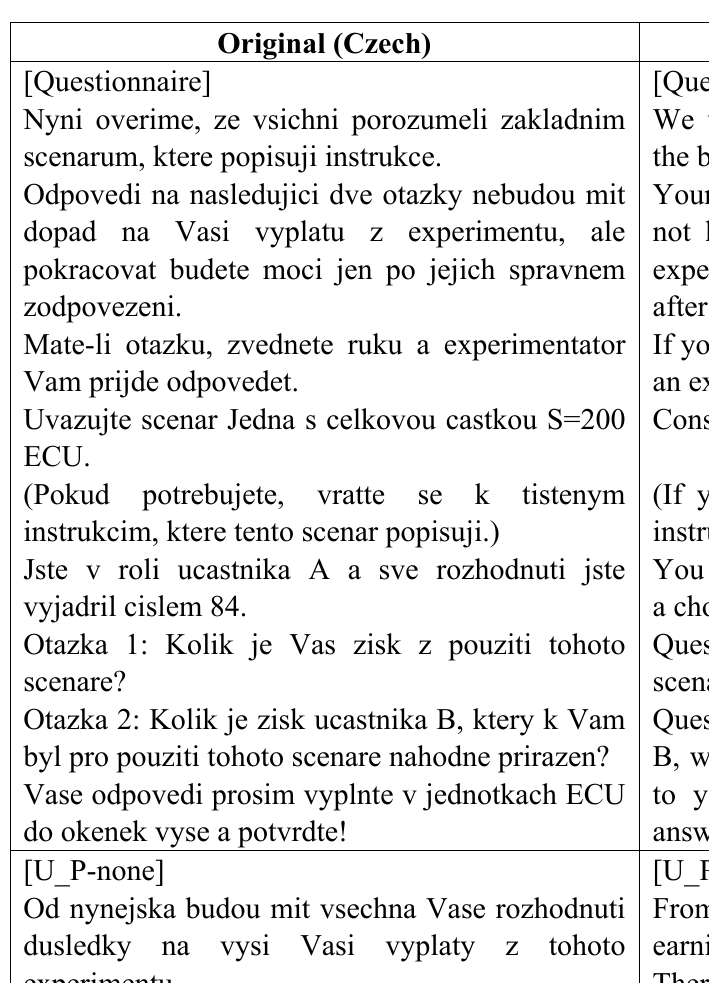
Table A.2. Instructions in the z-Tree